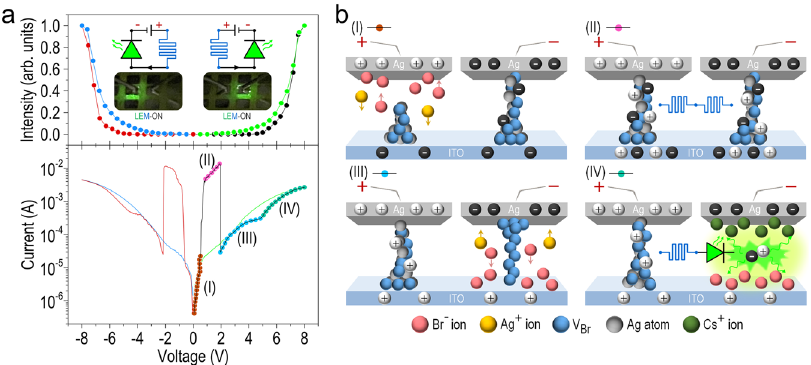
Fig. 6 Electro-optical characteristics of CsPbBr3 QD-based LEM and corresponding ionic migration processes. a Variations of EL intensity (top) and I-V characteristic (bottom) of the LEM when subject to a complete scanning cycle including both positive (0 V → + 8 V → 0 V) and negative (0 V → − 8 V → 0 V) voltage sweeps. The positive part of the I-V characteristic is divided into four regions to clarify the underlying mechanism for the observed optoelectronic characteristics of the CsPbBr 3 QD-based LEM. Insets: photographs taken while applying 8 V (right) and (cid:1) 8 V (left) to the LEM, showing the capability of the LEM for parallel optical and electrical readings. b Schematics illustrating ion migrations in the region of (I) – the Ag fi lament initiating at the bottom ITO electrode in the left device via the reduction process of Ag + cations. Meanwhile, a new V Br conducting channel is also rebuilt (also from the bottom to the top electrode) through a similar reduction process (V Br + + e − → V Br ). The current measured in region (I) is hence increased rapidly from ~ 1 × 10 − 7 to ~ 2 × 10 − 5 mA with the bias voltage, with the maximum current in this region restricted by the left device as its resistance is much larger than that of the right (i.e., equivalent to an ON-state RRAM in this stage).